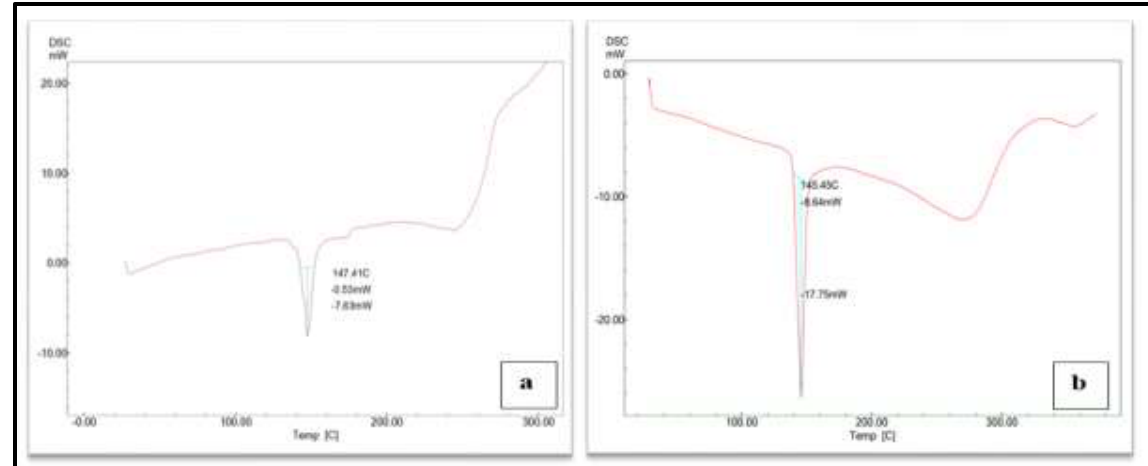
Figure 11. DSC of N1 (a), N2